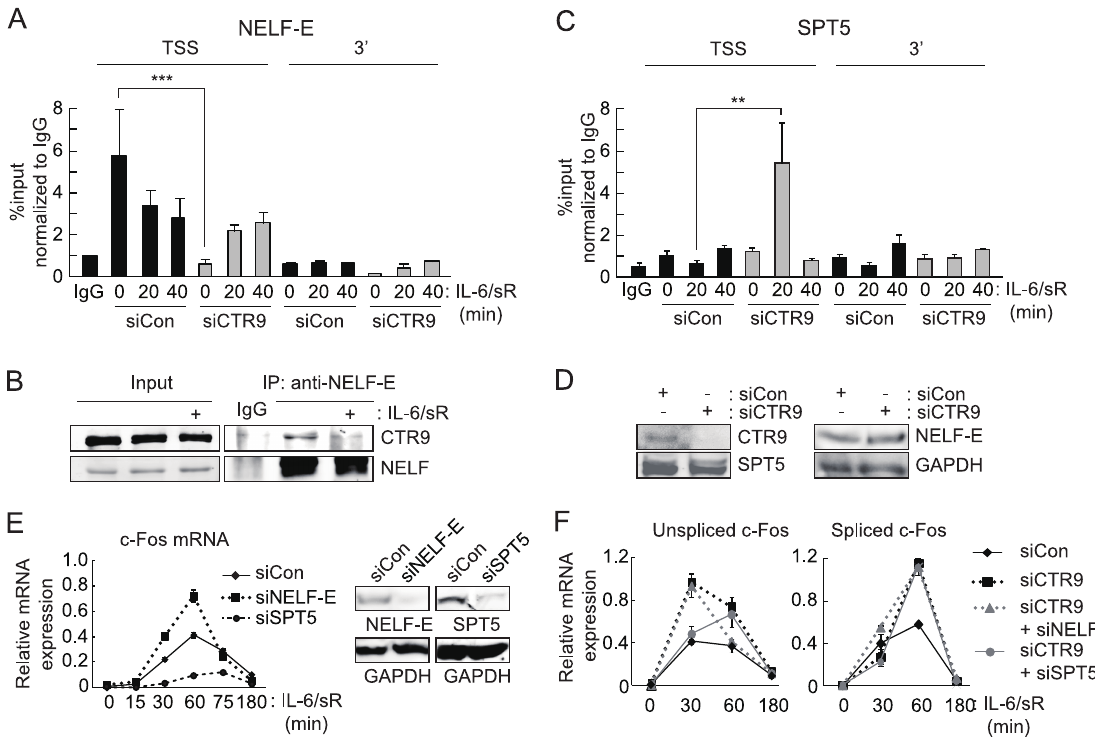
Figure 3. Recruitment of the negative elongation factor NELF to the c-Fos locus requires CTR9. Cells were transfected with control or CTR9 siRNA and treated with IL-6 and IL-6sR (20 ng/ml each) for the indicated length of time. ChIP analyses were performed with soluble chromatin using the antibodies indicated, and the bound DNA was analyzed by quantitative PCR using primers specific to c-Fos. Antibodies specific to NELF-E ( A ), or SPT5 ( C ), were used. B , Cells were treated with IL-6 and IL-6sR (20 ng/ml each) for 30 minutes and lysates were immunoprecipitated with anti- NELF-E antibody. Immunoprecipitated proteins were detected by western blot analysis. D , Cells were transfected with either control siRNA or CTR9 siRNA. Approximately 48 hours later, protein levels of CTR9, SPT5, NELF-E, and GAPDH were detected by western blot analysis. E , Cells were transfected with the indicated siRNAs and treated with IL-6 and IL-6sR (20 ng/ml each) for the indicated time period. The c-Fos mRNA induction level was measured by RT-qPCR. E , NELF-E and SPT5 knockdown efficiencies were measured by RT-qPCR (Left) and western blot analysis (Right). mRNA expression levels were normalized to b -Actin. F , Cells were transfected with the indicated siRNAs and treated with IL-6 and IL-6sR (20 ng/ml each) for the indicated time period. Expression levels were normalized to b -Actin. **p , 0.01, ***p , 0.001 by Student’s t test. Error bars represents SD (n=3).